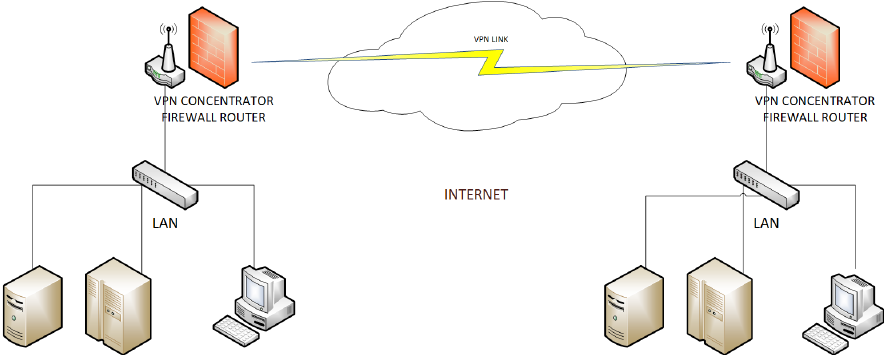
Figure 2. Site to Site VPN Scenario.